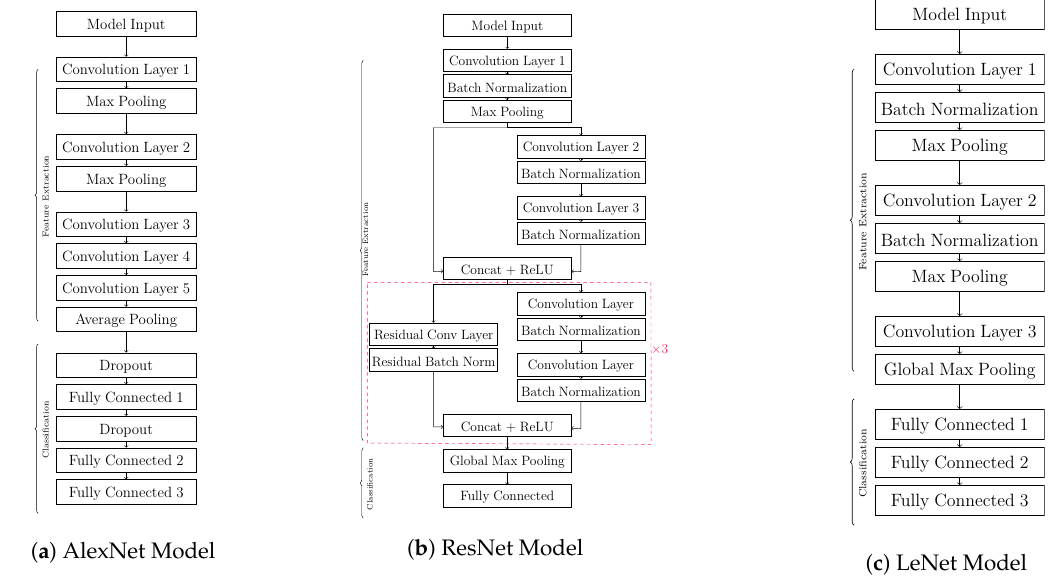
Figure 4. Block Diagram of CNN